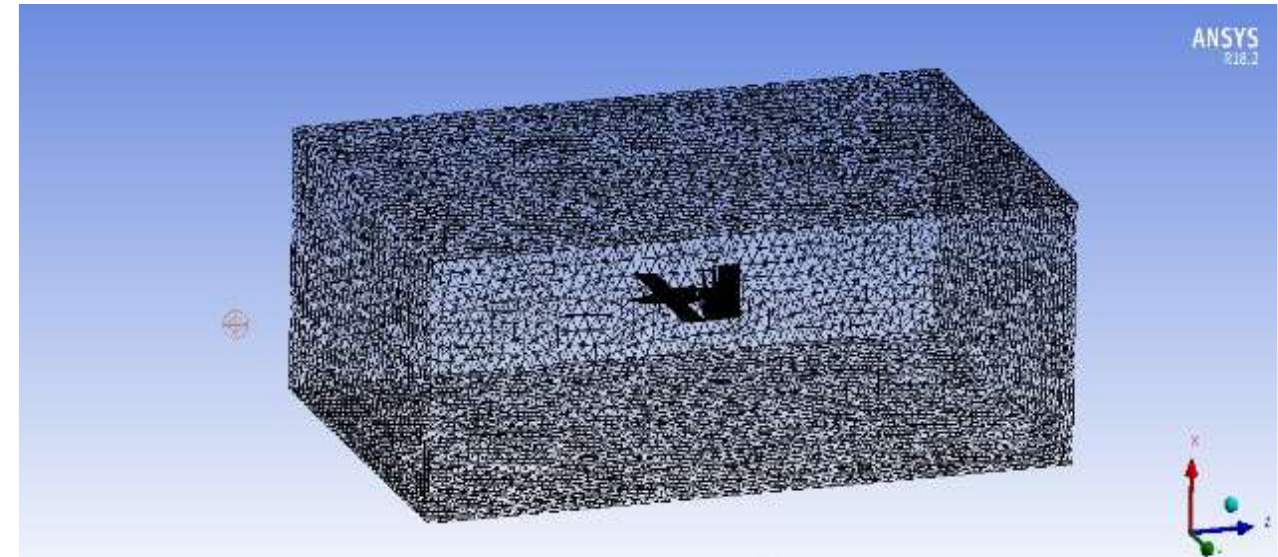
Figure 11. A discretized model of second model.